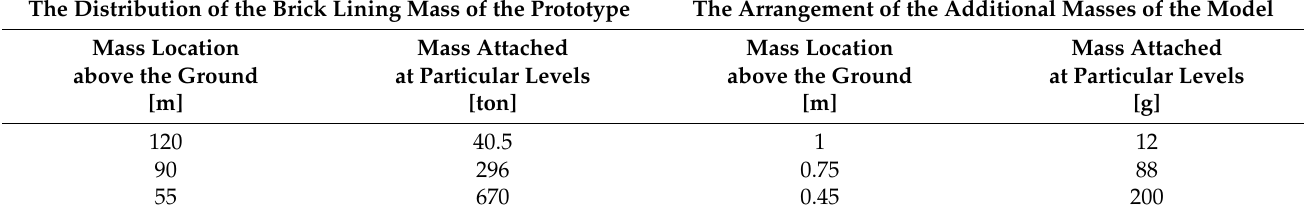
Table 5. The distribution of the brick lining mass of the chimney (the prototype), and the arrangement of the additional masses of the